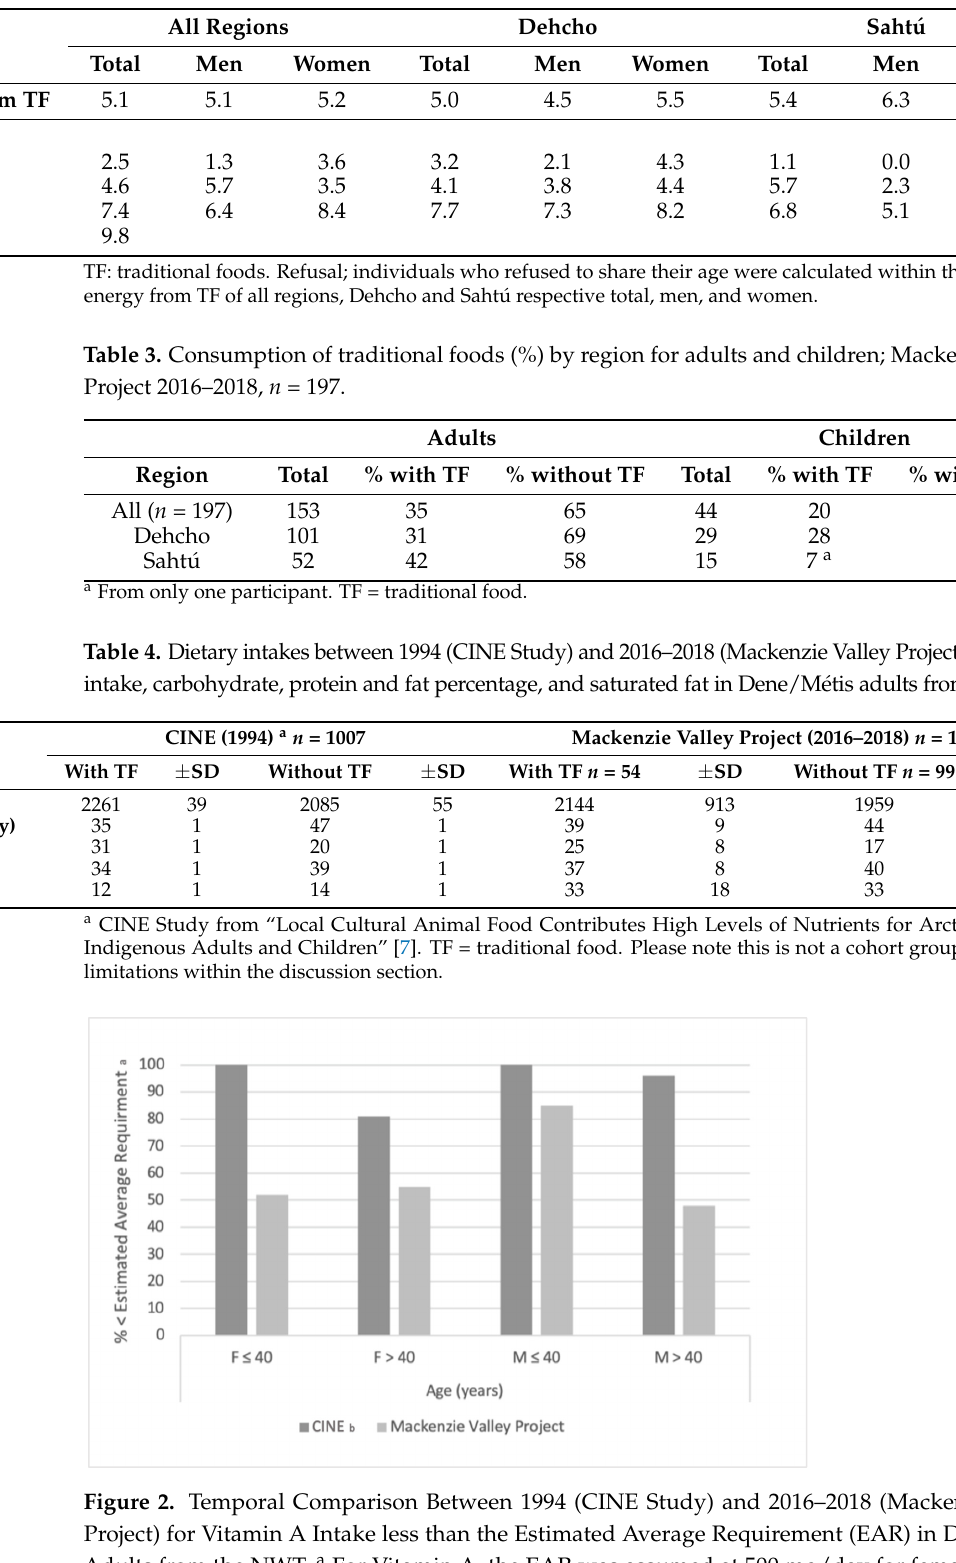
Table 2. Average energy from traditional foods (% of total energy) by region and sex; Mackenzie Valley Project 2016–2018.